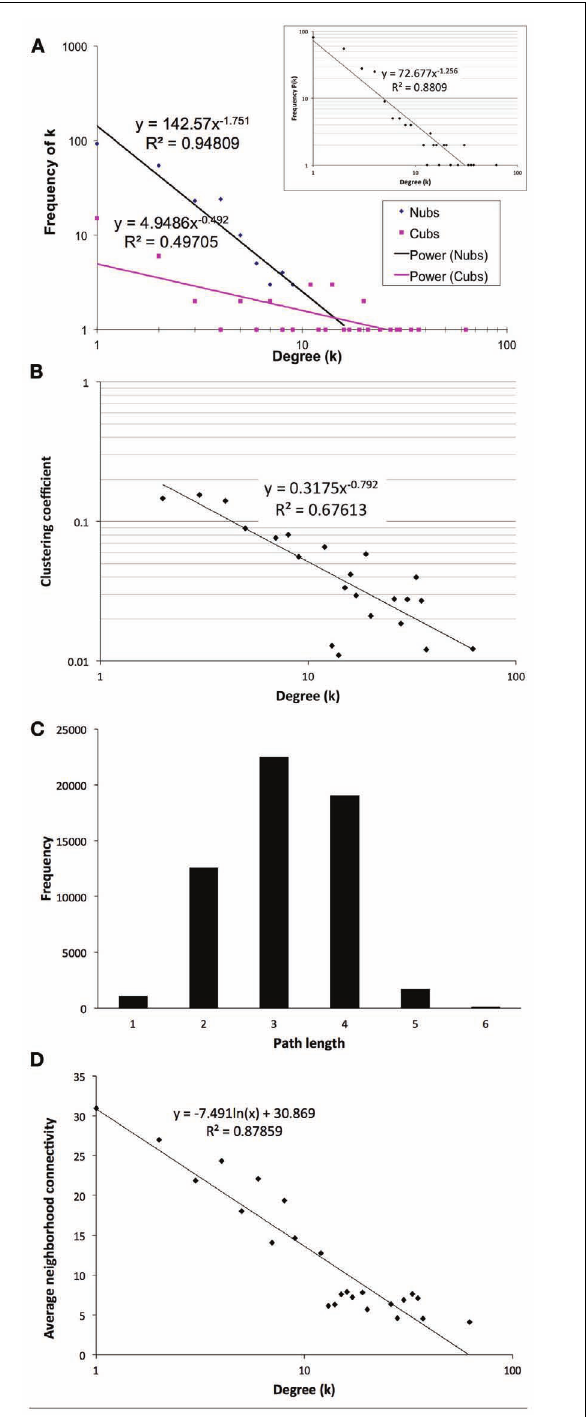
FIGURE 4 |Topological characteristics of our final network as measured by degree distributions of the Nub (blue diamonds) and Cub (pink squares) proteins in the final network (A) or total proteins [(A) inset], clustering coefficients as a function of degree suggesting a hierarchically modular structure (B), distribution of path lengths (C), and average neighborhood connectivity as a function of degree showing a disassortative network